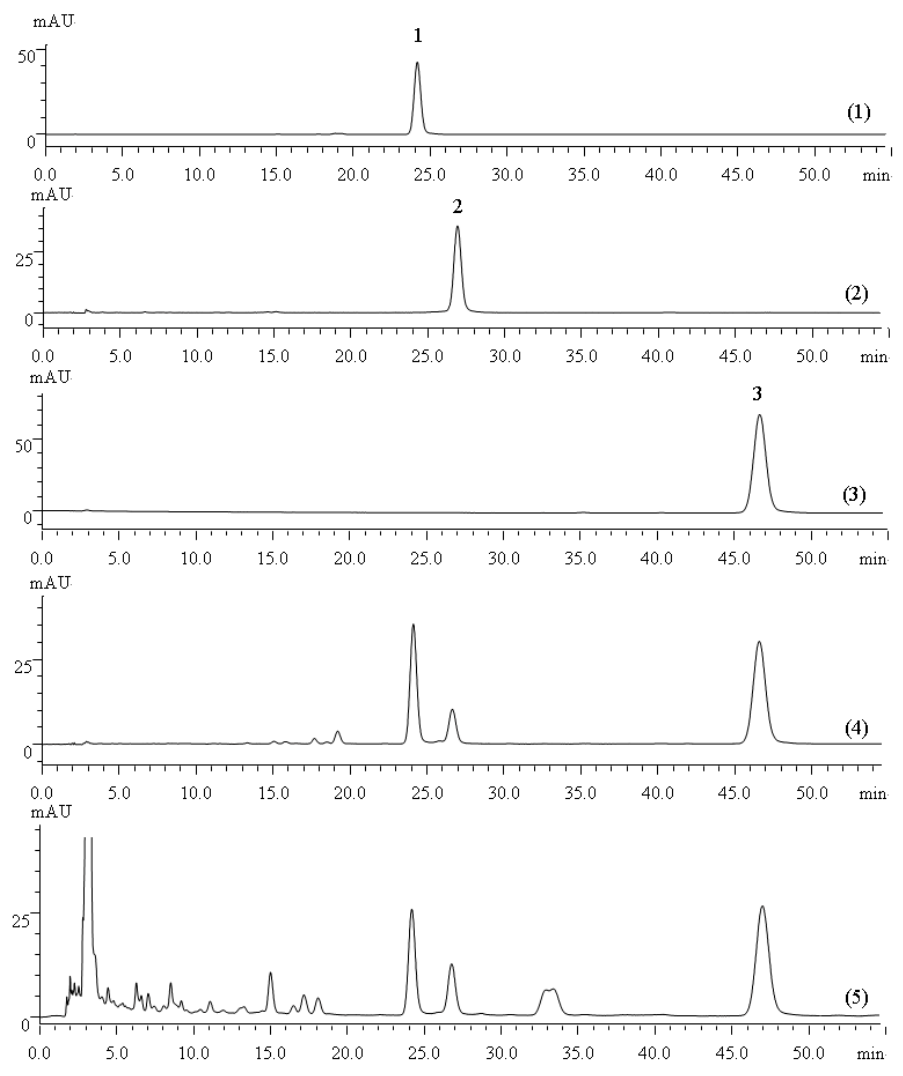
Figure 5. ( 1 ) HPLC chromatogram for the cryptotanshinone reference standard; ( 2 ) HPLC chromatogram for the tanshinone I reference standard; ( 3 ) HPLC chromatogram for the tanshinone IIA. reference standard; ( 4 ) HPLC chromatogram for the S. miltiorrhiza Bunge reference extractive; ( 5 ) HPLC chromatogram for the S. miltiorrhiza Bunge crude sample. Peak 1 : cryptotanshinone; Peak 2 : tanshinone I; Peak 3 : tanshinone